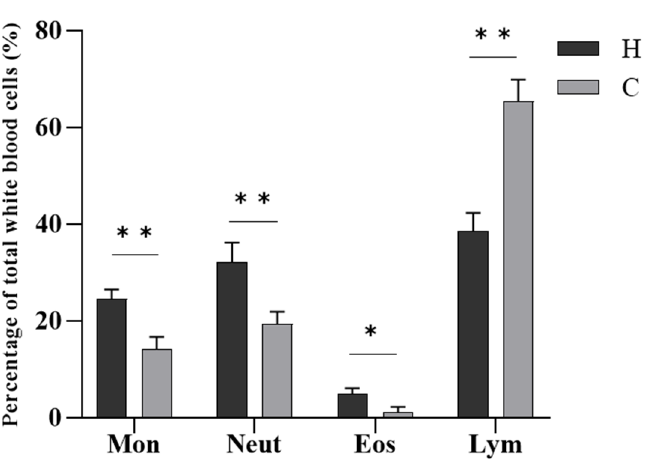
Figure 4. Differential leukocyte counts of hybrid sturgeon. Mon, monocytes; Neut, neutrophils; Eos, eosinophils; Lym, lymphocytes; H, diseased hybrid sturgeon (H-701); C, healthy hybrid sturgeon (Control); * p < 0.05; ** p < 0.01.